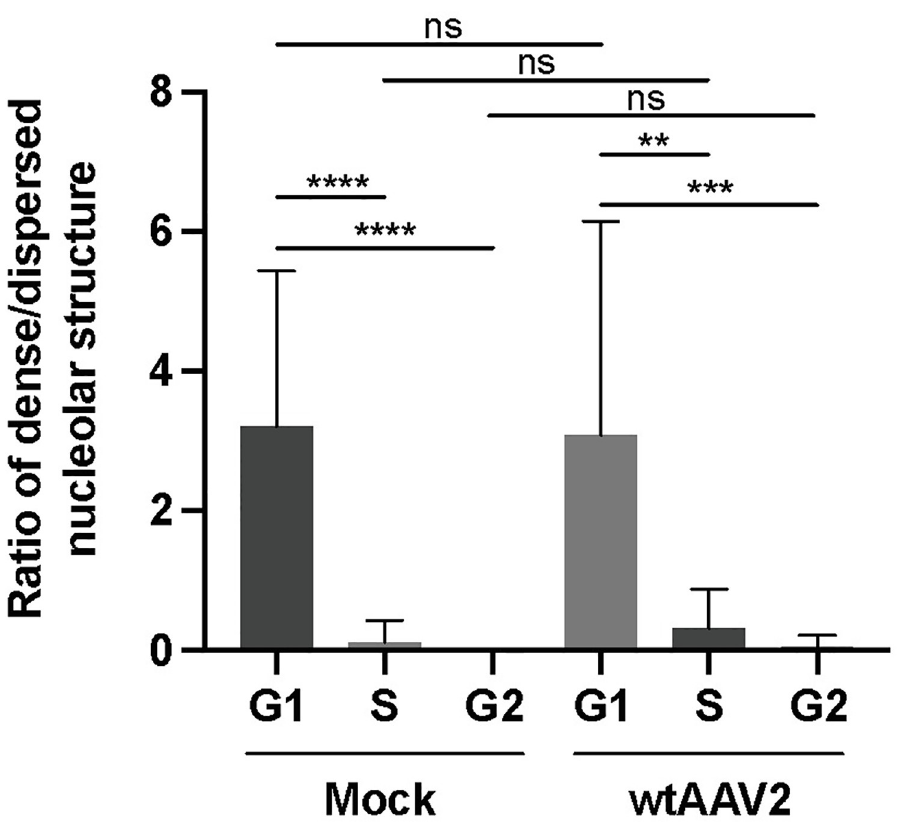
Fig 7. Nucleolar reorganization during cell cycle progression. Image-based analysis of the ratios of dense to dispersed nucleoli of 100 individual mock- or AAV2 infected cells in different cell cycle phases (G1, S and G2). p- values were calculated using an unpaired Student‘s t-test ( � —p � 0.05, �� —p � 0.01, ��� —p � 0.001, ���� — p � 0.0001).